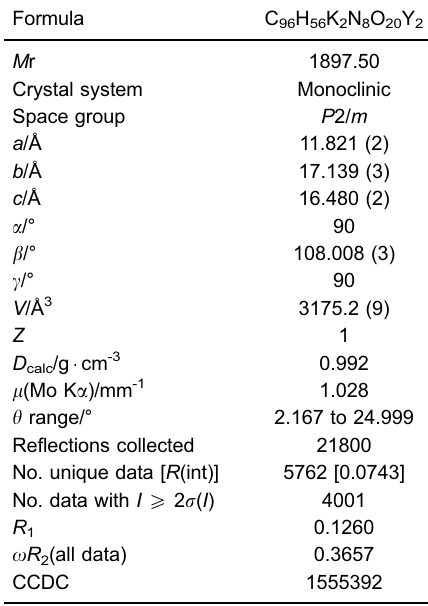
Table 1. Crystal data, data collection and structure re fi nement of complex 1. Formula